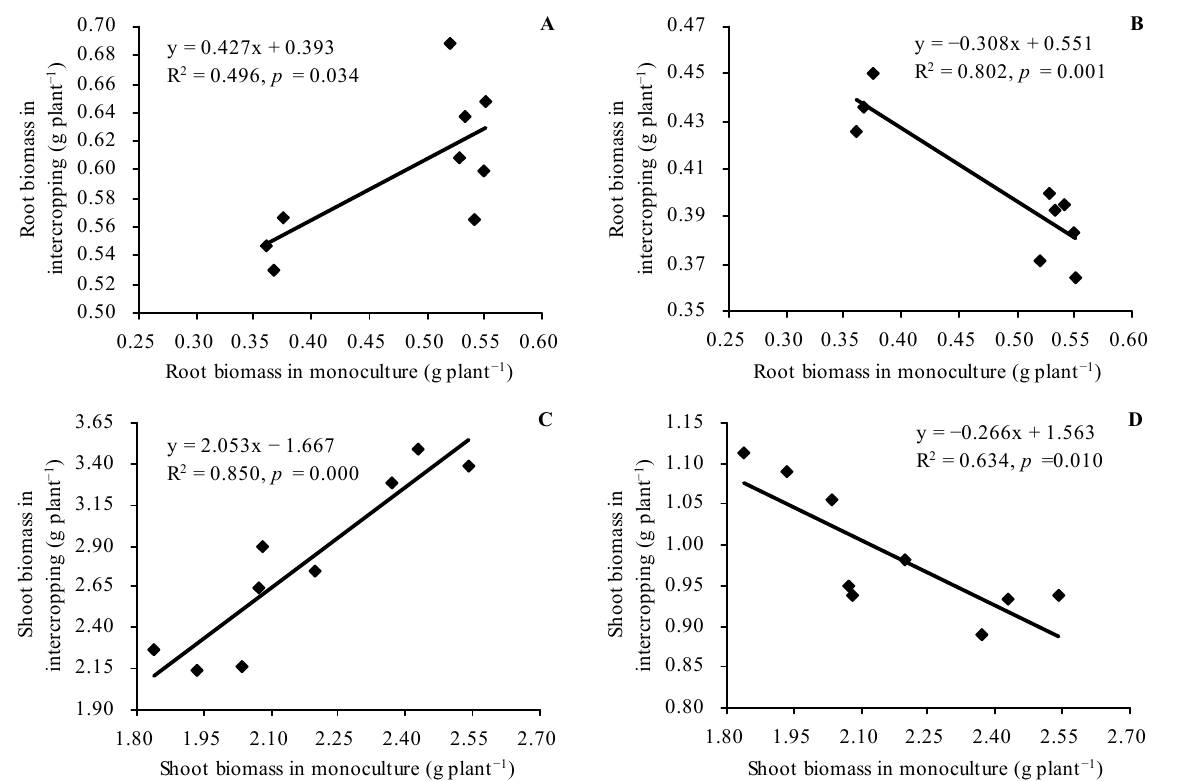
Figure 2. Linear regression relationships of plants’ biomass. ( A ) Root biomasses of diploid, tetraploid, and hexaploid in intercropping plotted against their root biomasses in monoculture; ( B ) root biomasses of C. betacea in intercropping plotted against root biomasses of diploid, tetraploid, and hexaploid in monoculture; ( C ) shoot biomasses of diploid, tetraploid, and hexaploid in intercropping plotted against their shoot biomasses in monoculture; ( D ) shoot biomasses of C. betacea in intercropping plotted against shoot biomasses of diploid, tetraploid, and hexaploid in monoculture. Table 1. Photosynthetic pigment contents in plants.